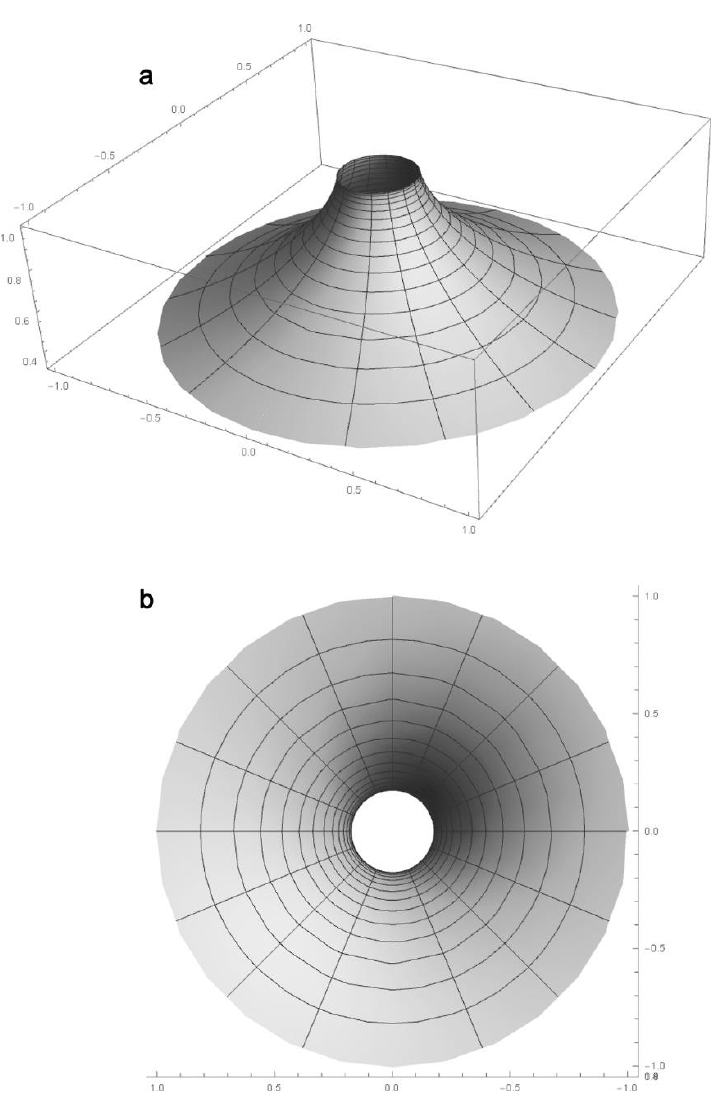
Figure 3. Elliptic pseudosphere generated by Equation (6) with r = 0.175 mm and R = 2.75 mm as the geometrical representation of the human macula: lateral view ( a ) and axial view ( b ). The graph has been realized using Wolfram Mathematica 10.